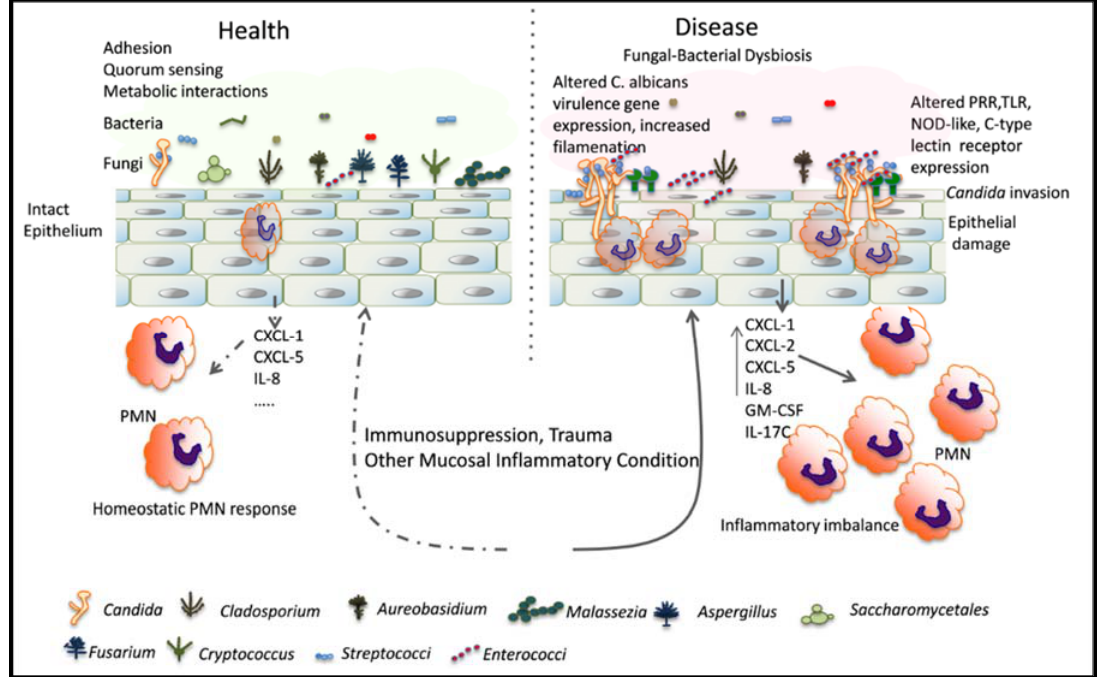
Figure 1. Relationship between C. albicans and resident mucosal bacteria in heath and disease: Immunosuppression is associated with a dysbiotic state characterized by overgrowth of Candida and certain resident bacterial species. Bacteria may interact with Candida species to augment the mucosal inflammatory response, resulting in epithelial damage. Alternatively, bacteria can directly influence filamentation and virulence gene expression to increase mucosal invasion. PRR: pattern recognition receptors; TLR: toll-like receptors; NOD: nucleotide-oligomerization domain.